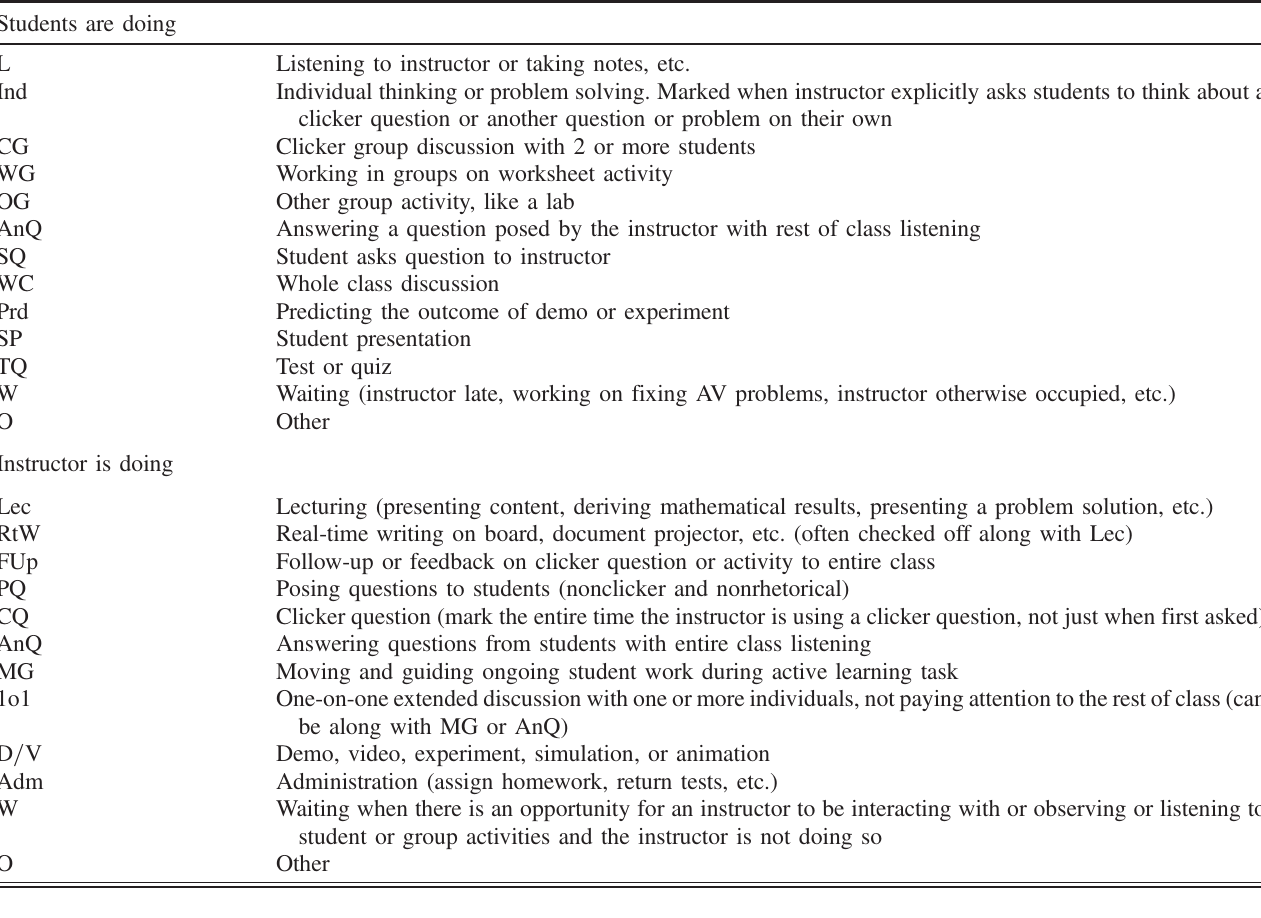
TABLE I. COPUS codes for instructor and student activities. We have summarized the descriptions for brevity, but the full code descriptions can be found in Smith et al.